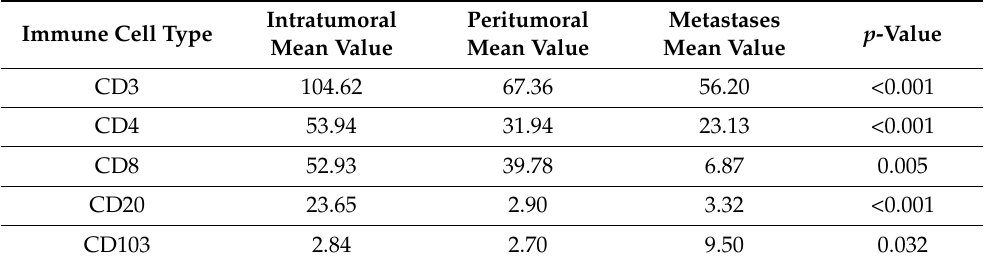
Figure 2. The main density of lymphocytes in ccRCC infiltrating the central and peripher tumor, and metastases (CD103 p = 0.032, Kruskal–Wallis-test). Table 4. Comparison of the immune cell infiltration between primary tumors and paired metastases (Kruskal–Wallis test, Bonn cohort, n = 25 patients).